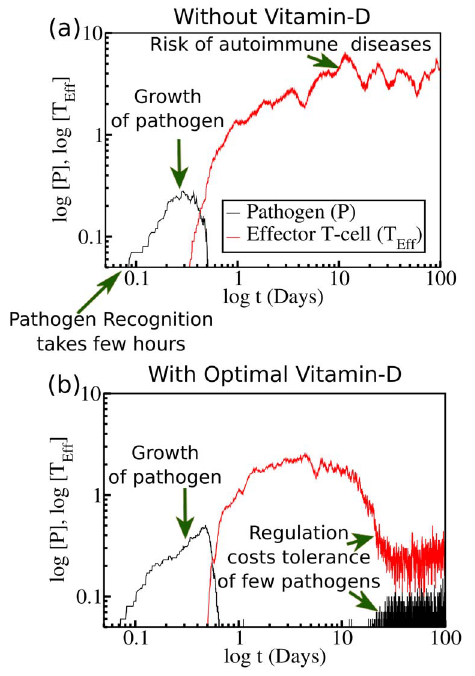
Figure 4. Time evolution of immune response. The dynamical variation of pathogens and effector T-cells are calculated both (a) in absence and (b) in presence of optimal level of vitamin-D. In both cases adaptive response sets in after few hours of the pathogenic incursion. Pathogen annihilation process starts after recognition of the pathogen by APCs and subsequent APC mediated T-cell activation. (a) In absence of vitamin-D, only the weak, inhibitory control of regulatory T-cells on the production of effector T-cells results in an elevated steady state concentration of T Eff cells. This may increase the risk of autoimmune diseases. (b) The presence of vitamin-D exerts greater control over the production of T Eff cells. Upon pathogen load clearance, the number of effector T-cells also becomes significantly suppressed. This may decrease the risk of autoimmune diseases. At the same time, note the re-entrant possibility of pathogen which up to certain level assists to build an adaptive tolerance of the immune system. (In both cases k inp , k rese are so chosen that they remain in the bistable region ( k inp ~ 10, k rese ~ 100) as shown in Figure 3. The other rate constants considered here are similar to Figure 2.